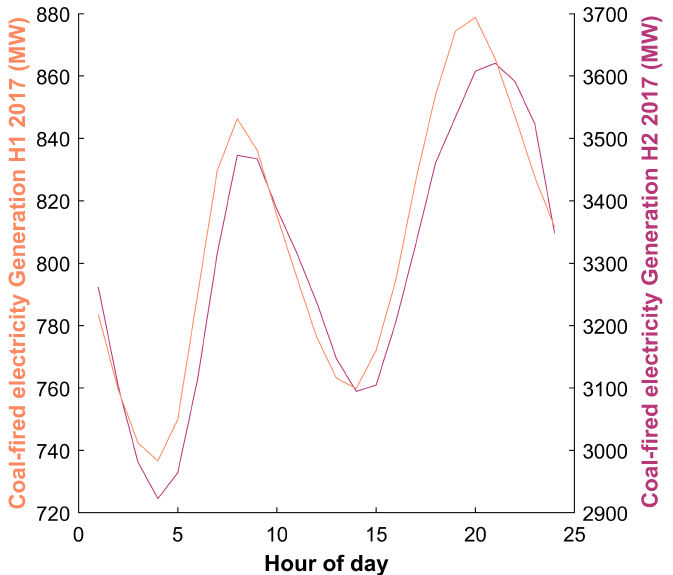
Figure A2. Average hourly coal-fired electricity generation in Italy in first half 2017 (left y-axis) and second half 2017 (right